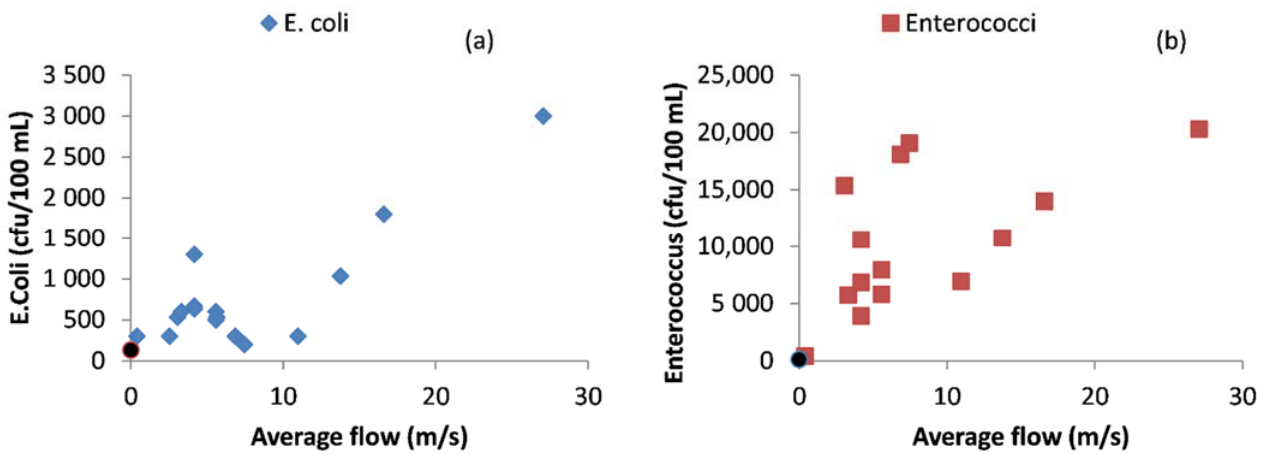
Figure 6. Relationship between flow rate and E. coli ( a ) and Enterococcos ( b ) (the black dots represent dry weather flow data).